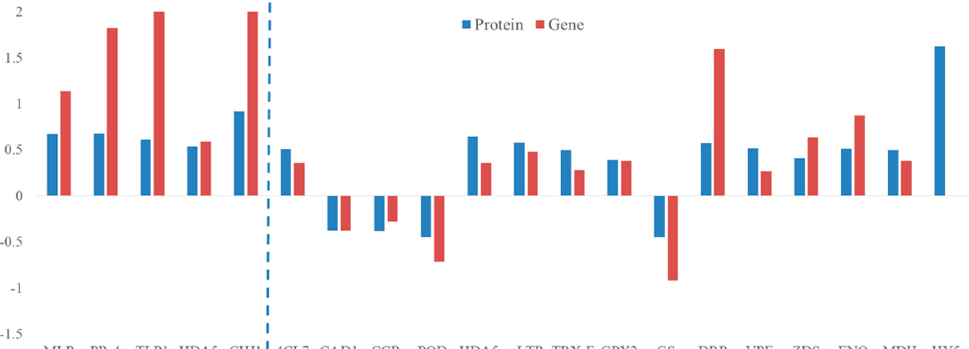
Figure 7. Effect of BABA treatment on expression level of selected genes in mango fruit.